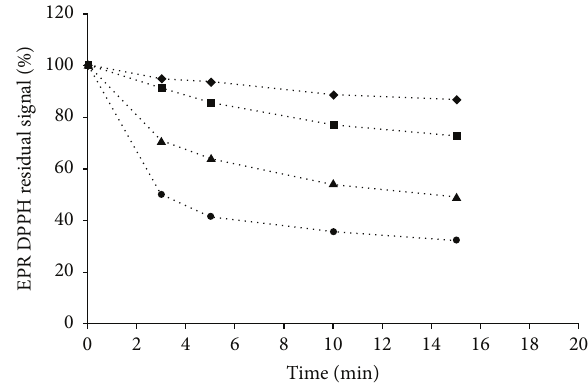
Figure 1: Quenching of radical activity by (+)-catechin solutions with time. 8 𝜇 M (diamonds), 24 𝜇 M (squares), 40 𝜇 M (up triangles), and 56 𝜇 M